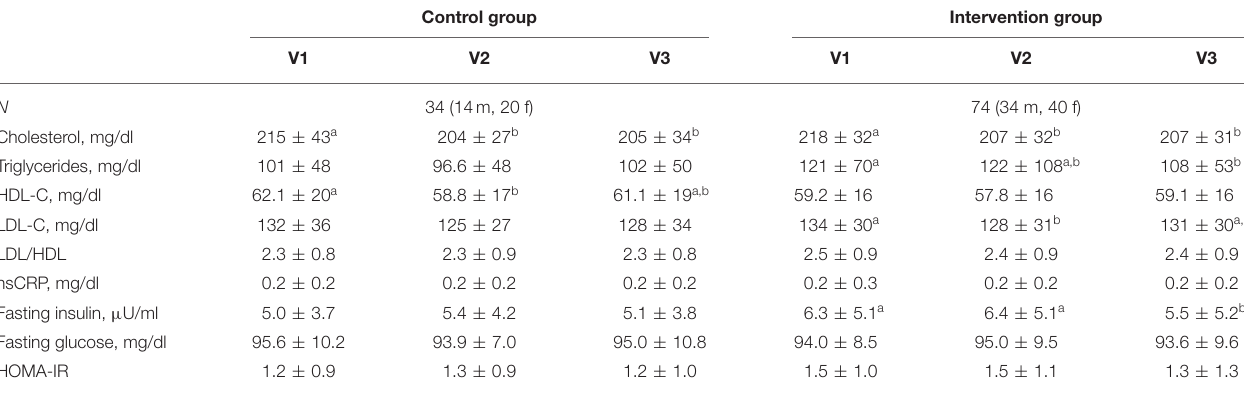
TABLE 3 | Changes of selected metabolic parameters in the intervention and control group during the 12-week study period. Control group Intervention group V1 V2 V3 V1 V2